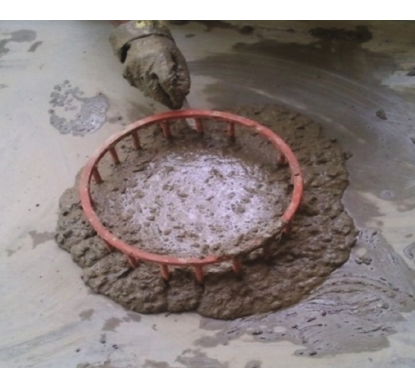
Figure 4: J-ring test.